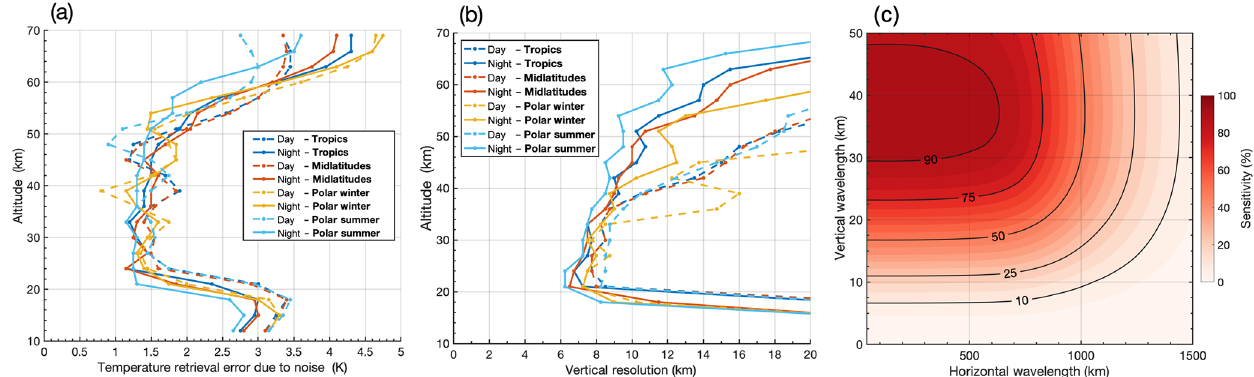
Figure 2. Estimated temperature retrieval errors (a) and vertical resolutions (b) for the 3-D AIRS temperature measurements against altitude for different atmospheric conditions, based on latitude and season. Dashed and solid lines indicate the daytime and nighttime retrievals respectively. Panel (c) shows estimated sensitivity of the detrended 3-D AIRS temperature perturbations to waves with different vertical and horizontal (across-track) wavelengths for observations made under average atmospheric conditions at an altitude of z = 40km. For details, see text in Sect.